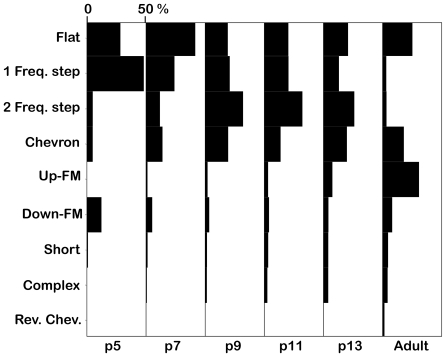
Changes in the proportions of syllable types across postnatal development.Each column shows proportions of most common syllables at the specified age. The proportions of the noisy syllable are not shown as it was only produced very rarely by adult mice, representing only 0.6% (44/6936) of syllables.